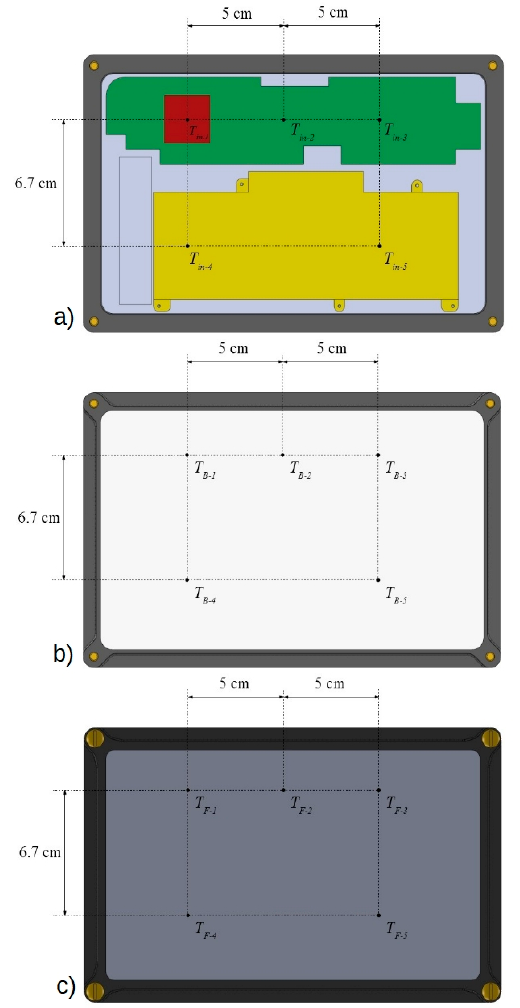
Figure 4. Rendering of the mock tablet showing the location and designation of the thermocouples attached to the ( a ) internal components, ( b ) back cover, and ( c ) front display.